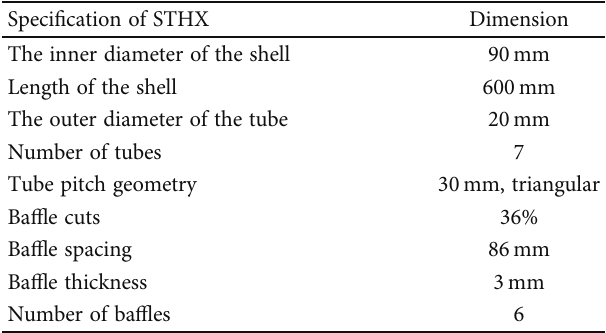
Table 3: Geometric dimension of STHX.